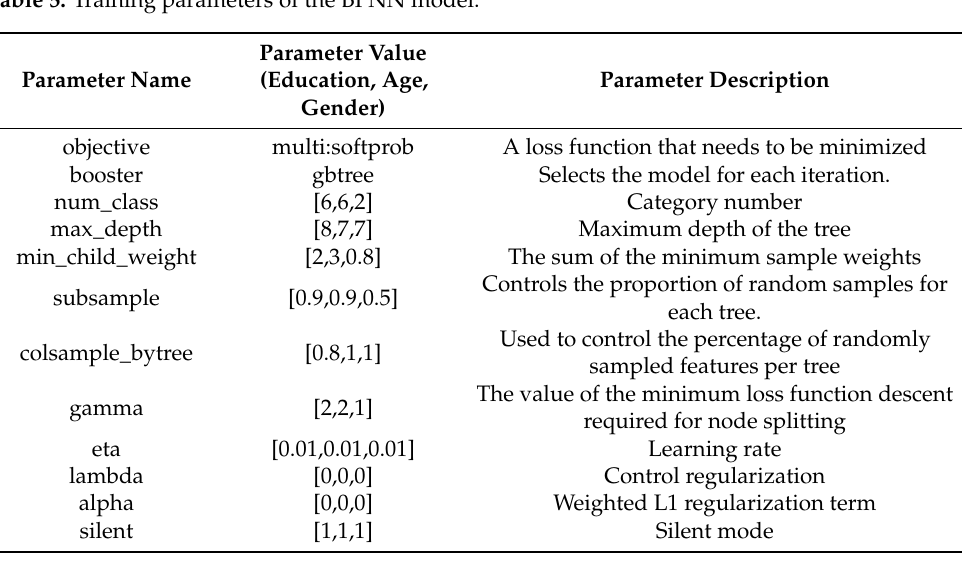
Table 5. Training parameters of the BPNN